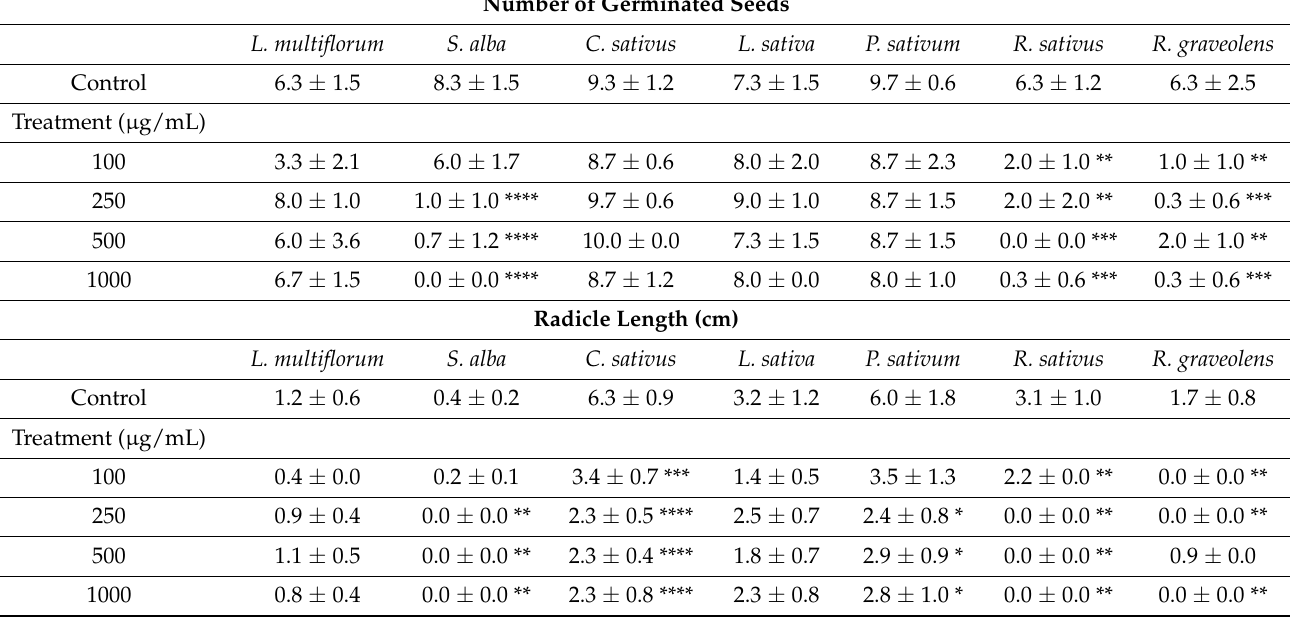
Table 3. Phytotoxic activity of the E. cinerea essential oil applied at different concentrations ( µ g/mL) to seeds of diverse plant